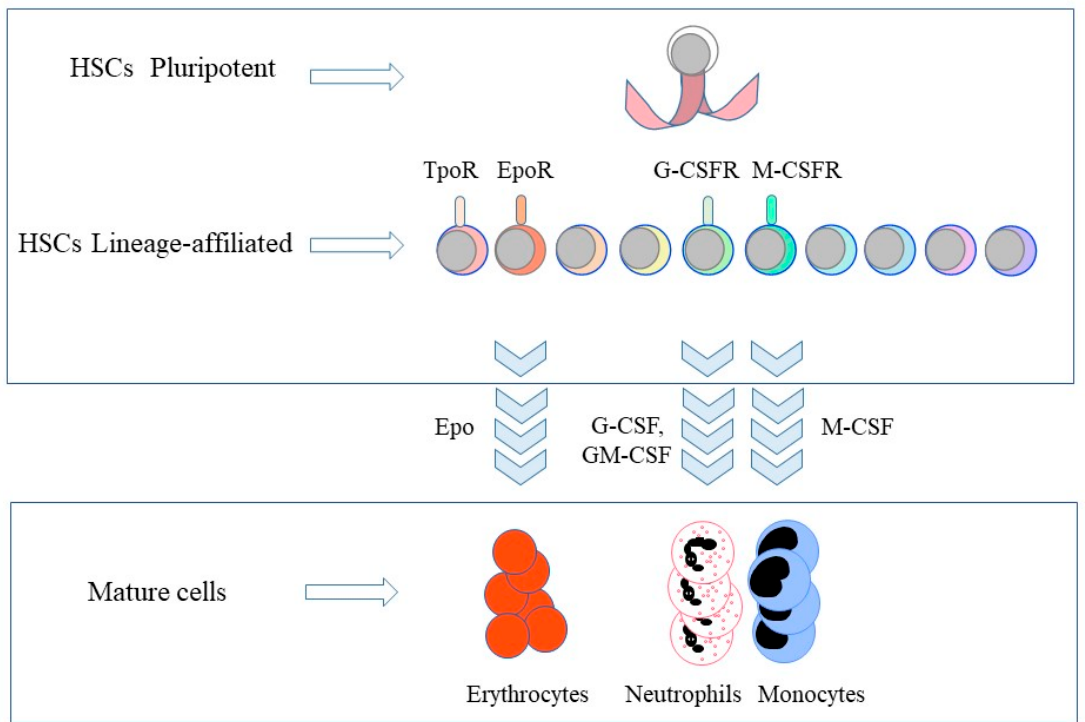
Figure 1. The expression of lineage-affiliated cytokine receptors by hematopoietic stem cells and the lineage instructive cytokines. Hematopietic stem cells (HSCs) express the receptors (R) for thrombopoietin (Tpo), erythropoietin (Epo), granulocyte colony-stimulating factor (G-CSF) and macrophage colony-stimulating factor (M-CSF). Epo commits HSCs and multipotent HPCs to erythropoiesis. M-CSF instructs myeloid fate in HSCs and macrophage fate in granulocyte/macrophage progenitors. G-CSF and granulocyte/macrophage colony-stimulating factor (GM-CSF) provoke the generation of neutrophils from granulocyte/macrophage progenitors. TpoR, thrombopoietin receptor; G-CSFR, granulocyte colony-stimulating factor receptor; M-CSFR, macrophage colony-stimulating factor receptor.